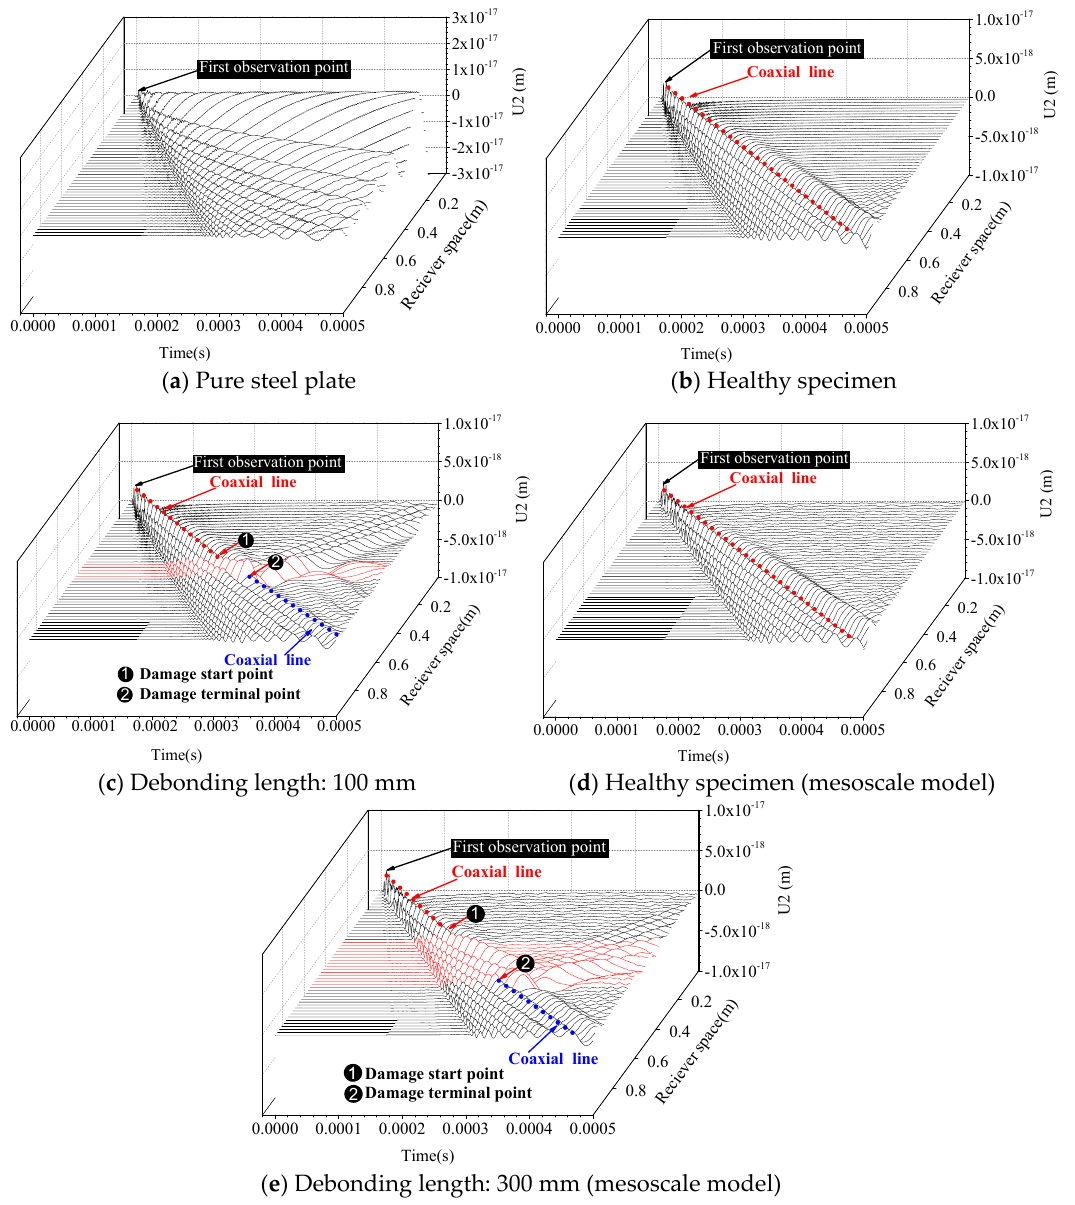
Figure 11. Time history displacement curve obtained with the MASW method.